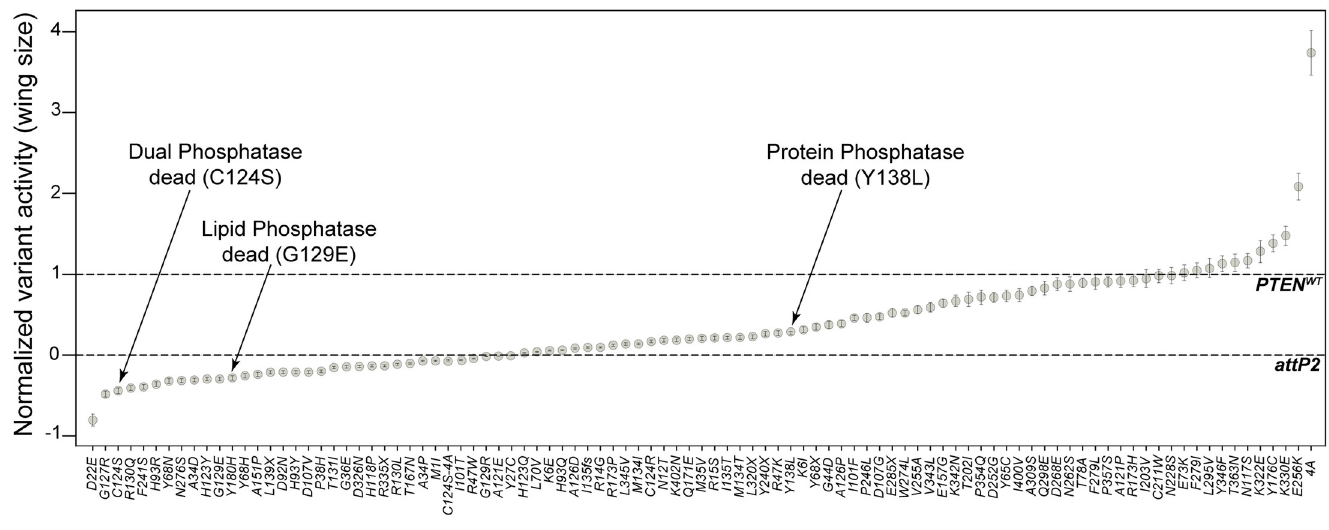
Fig 5. Functionalization of human PTEN variants using the wing size assay. 97 UAS-PTEN variant flies were crossed to omb > PI3K act females and progeny were assessed for wing size (see S1 Table). Graph showing normalized variant activity of PTEN variants where attP2 (no PTEN ) = 0 and PTEN-WT = 1. Each datum point indicates a normalized variant mean. Data are expressed as normalized mean. Error bars indicate propagated error (relative standard deviation).